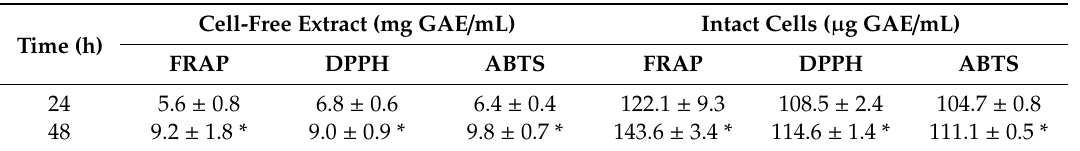
Table 2. FRAP, DPPH and ABTS antioxidant activity of cell-free extract and intact cells obtained from co-production of gallic acid and viable cells of S. ruineniae